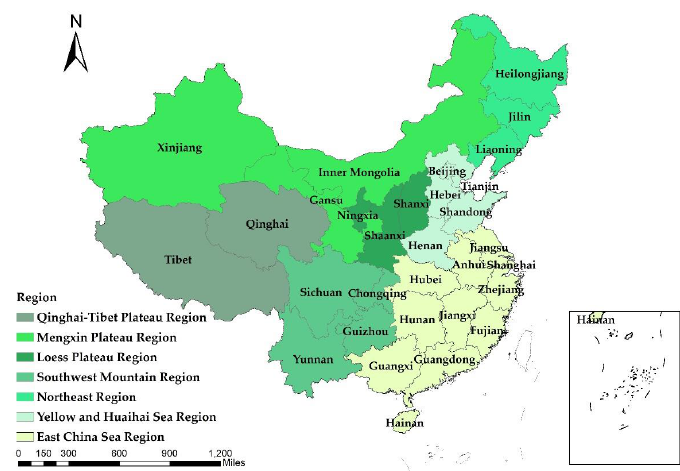
Figure 3. Division of the livestock geographical regions.